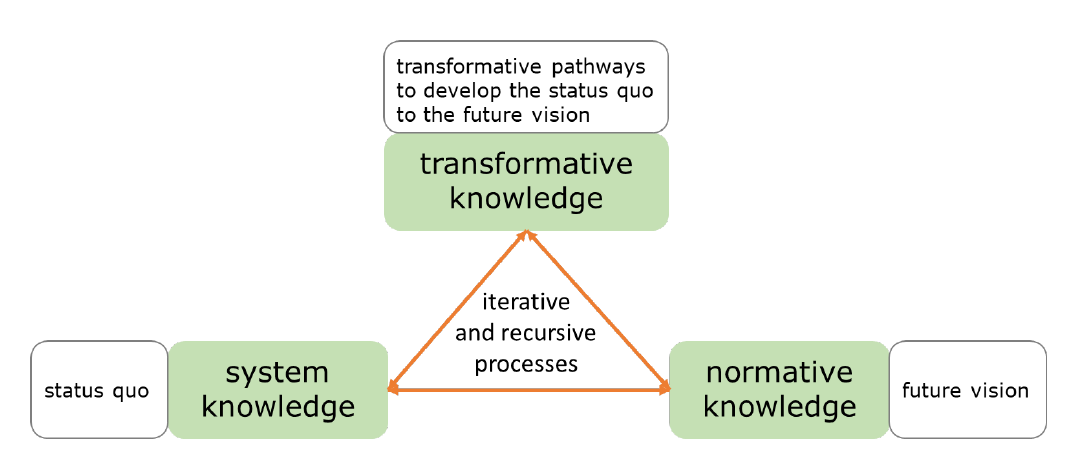
Figure 2. Guiding framework for the sustainability performance of an IS system.